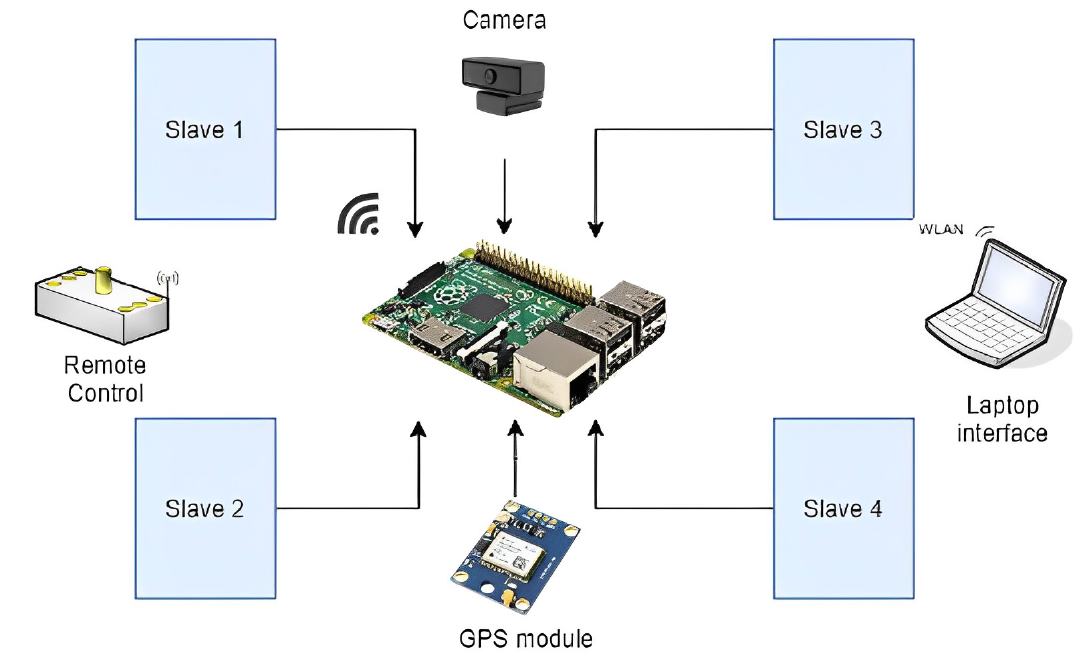
Figure 4. Electronics’ architecture comprised of four slaves and a master with two input options.